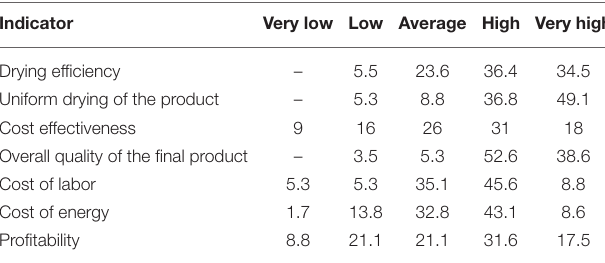
TABLE 3 | Perceptions of processors of the performance of flash